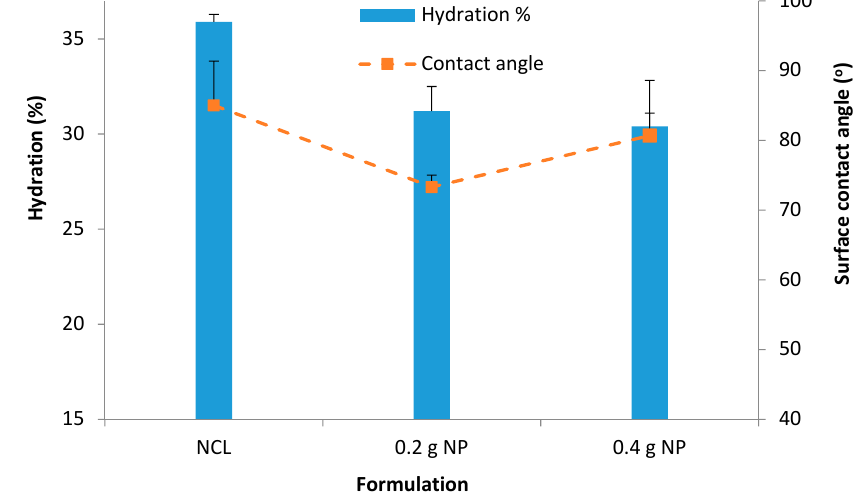
Figure 8. Hydration % for unloaded NP contact lenses, contact lenses with 0.2 g prednisolone nanoparticles and 0.4 g prednisolone nanoparticles. Data presented as mean + standard deviation, n = 3.